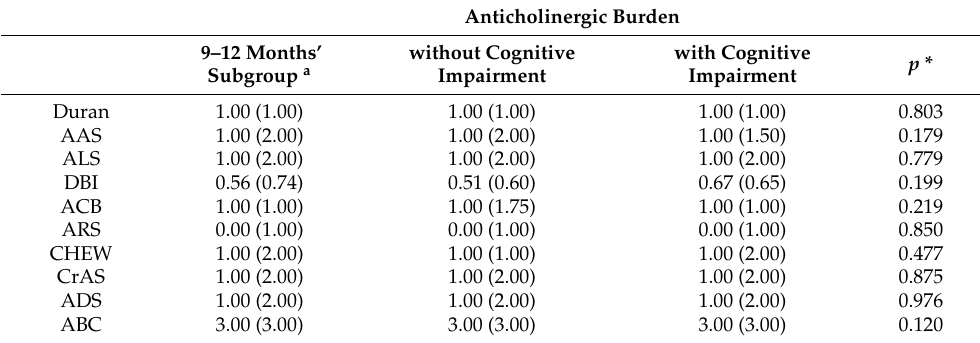
Table A5. Anticholinergic burden by all the scales in subgroups of patients evaluated on 9–12 months, with and without cognitive